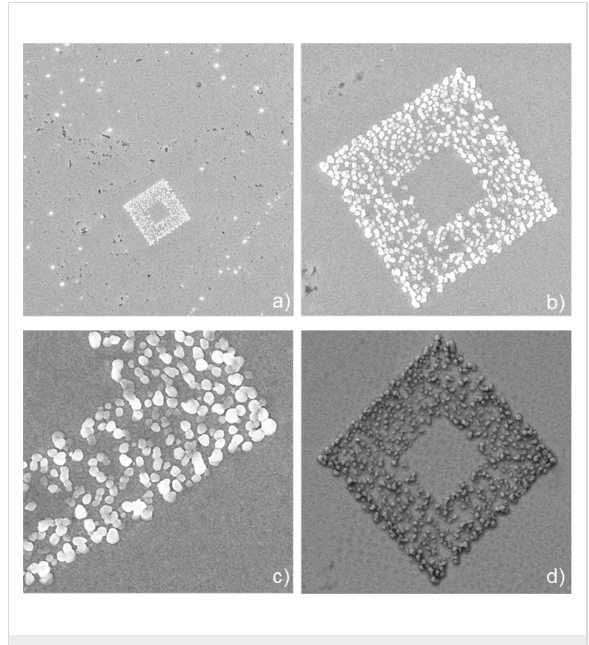
Figure 3: SEM image demonstrating the ex situ stability of the tip- induced electrochemically deposited copper islands on a gold sub- strate. (a–c) SEM image immediately taken after deposition, (d) SEM image of the same sample area after 1.5 years. Scan size: (a) 32 µm ×